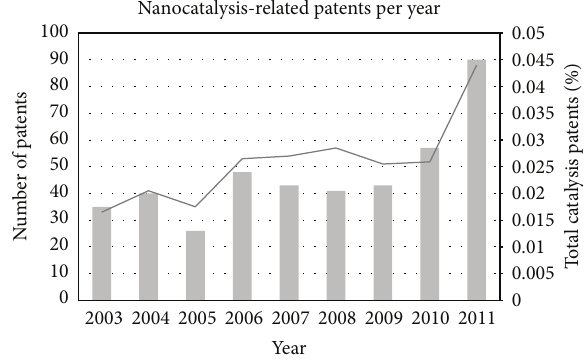
Figure 4: Development of number of patents granted in the field of nanocatalysis since 2003 (based on a research on the US Patent and Trademark Office Patent Database (http://patft.uspto.gov/) applying the working definition stated in the beginning of this